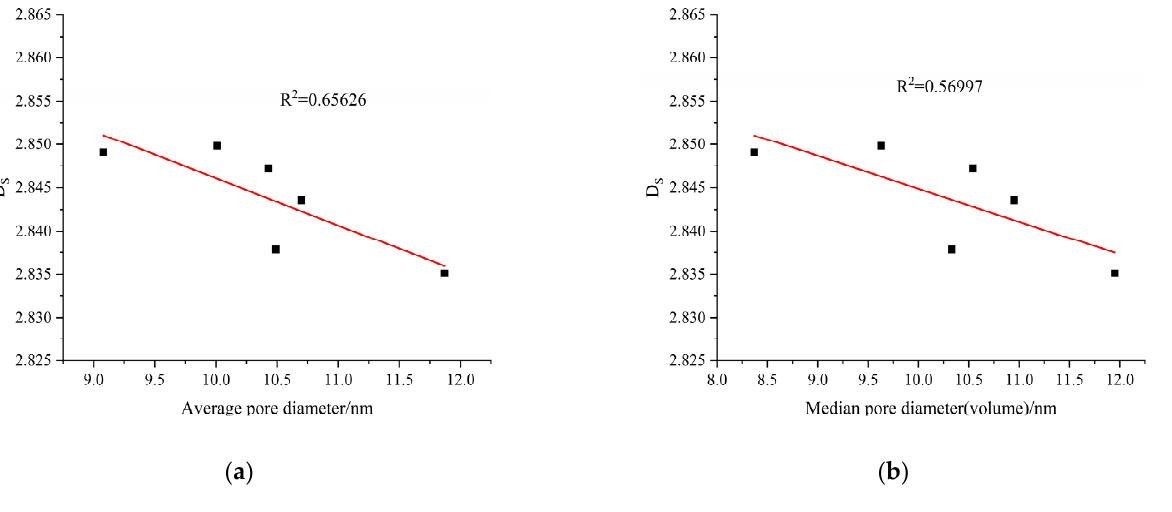
Figure 15. Relationships between the fractal dimension and average pore size and median pore size.